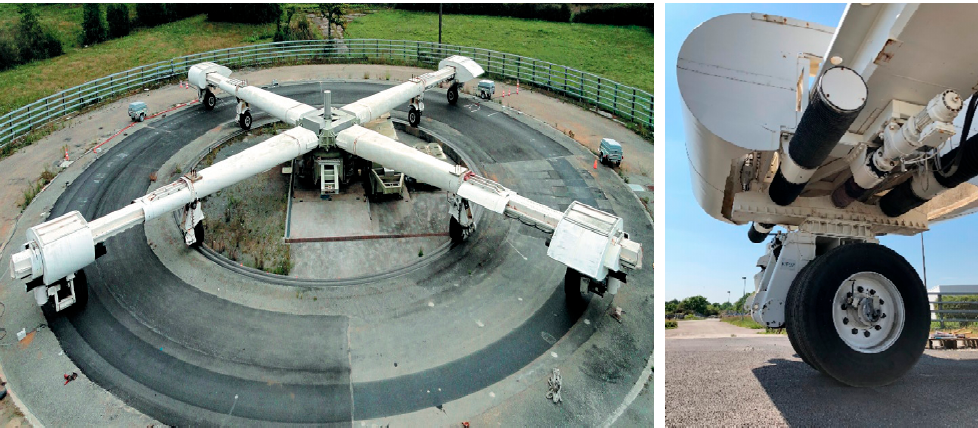
Figure 2. Fatigue carrousel for accelerated pavement tests, Nantes—France.